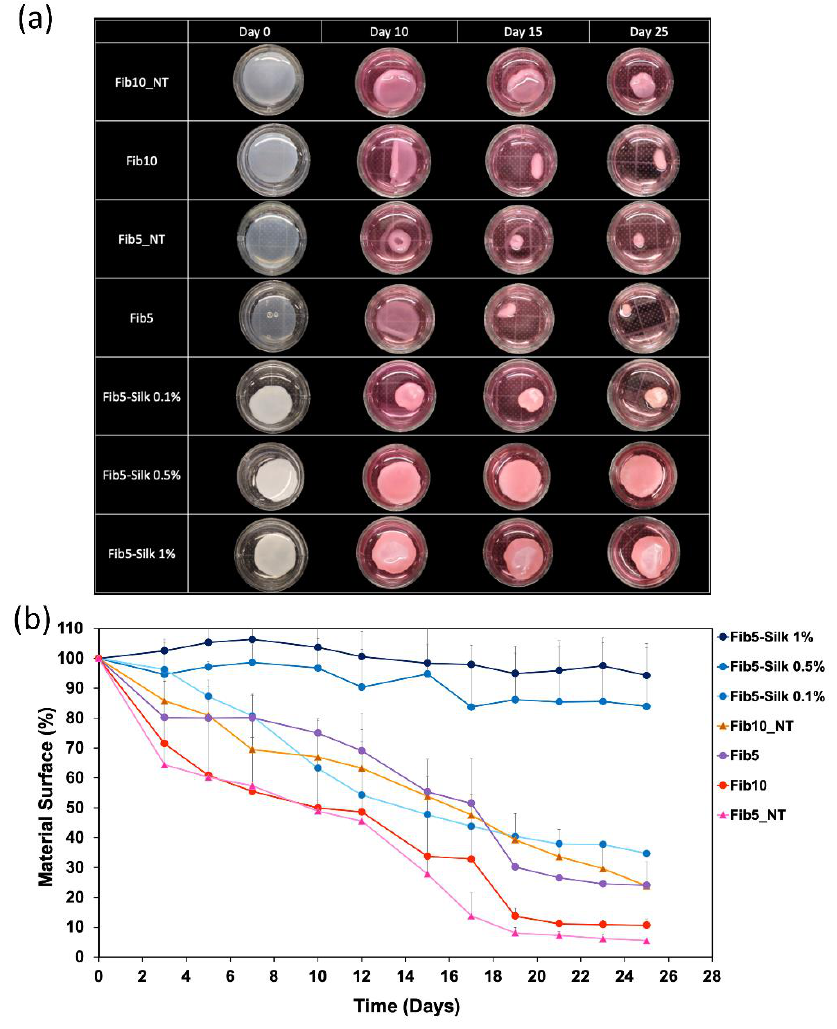
Figure 7. Evaluation of scaffold cell-mediated contraction over time. ( a ) Image of each scaffold before culture (time 0) and at different time points (10, 15 and 25 days) of culture with human arterial smooth muscle cells (HUASMCs). ( b ) Evaluation of cell-induced surface contraction of the fibrin/ silk fibroin scaffolds, at different time points of cell culture with HUASMCs at 37 °C and 5% CO 2 . The data are expressed as percentage of the initial surface. The data are reported as mean ± SD ( n = 3).